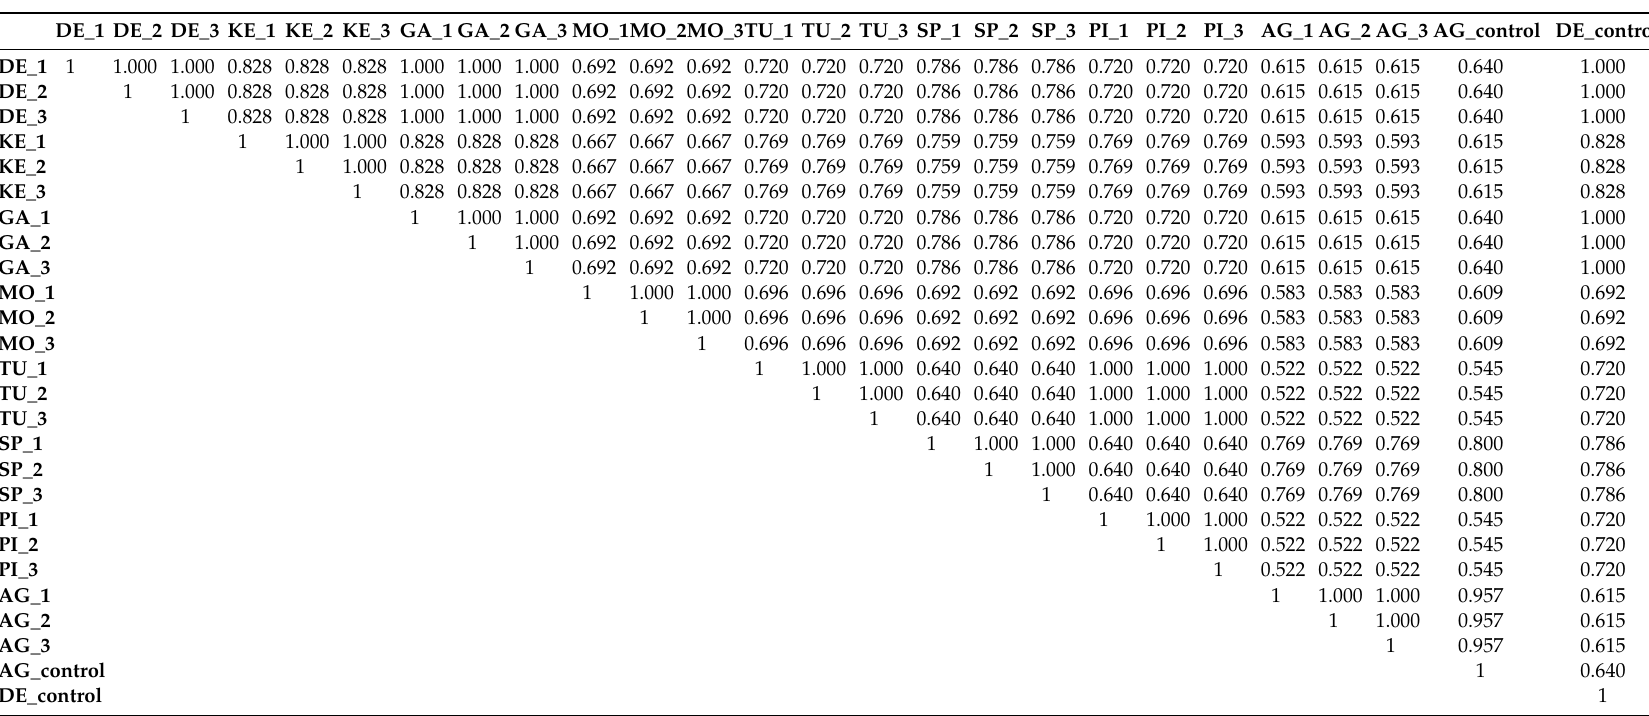
Table A3. Dice similarity matrix of the eight potato genotypes based on SSR markers. Two control varieties (AG and DE) are also